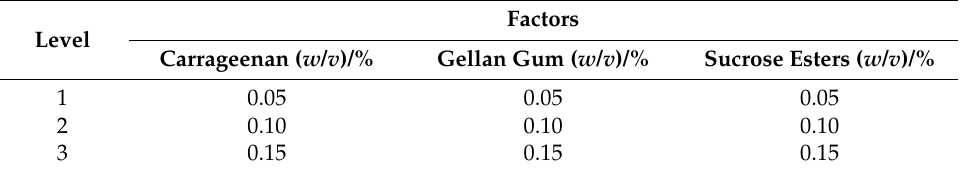
Table 4. The factor and level of orthogonal experiment for stabilizer of goat milk catalyzed by CEP of L. plantarum